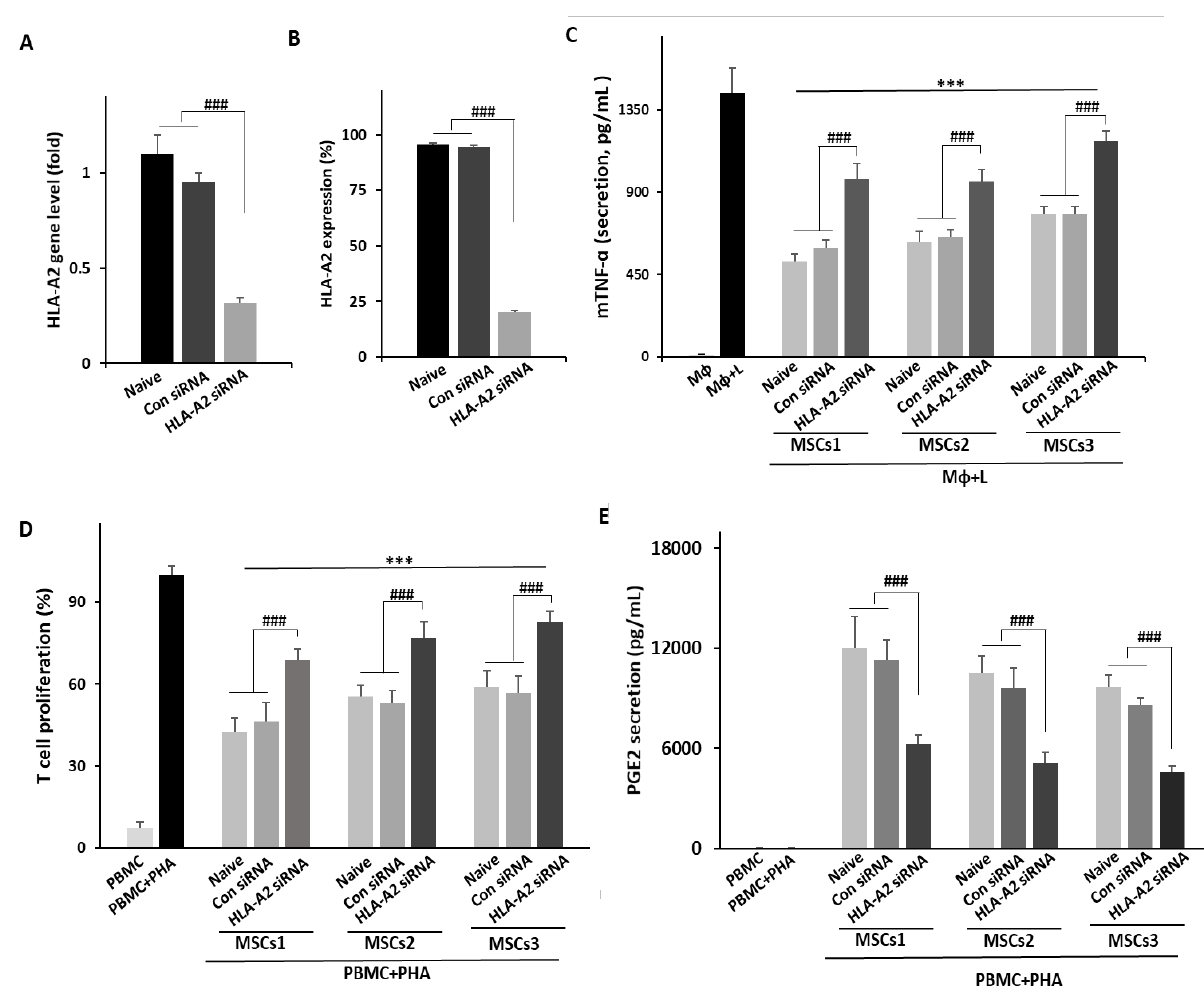
Figure 5. HLA-A2 knockdown in MSCs attenuates their therapeutic effects in vitro. Cells were transfected with control siRNA or HLA-A2 siRNA. ( A ) Gene expression and ( B ) protein levels of HLA-A2 were compared relative to those in non-transfected MSCs (naïve). ( A , B ) Error bars represent means ± SD, n = 3 per group; ### p < 0.001. ( C , E ) MSCs from three different lots of Group 1 were evaluated to confirm their therapeutic effects in vitro. ( C ) HLA-A2 siRNA-treated MSCs were co- cultured with LPS-induced RAW 246.7 cells and TNF- α levels were assessed via ELISA. Lower levels of TNF- α were detected in media from HLA-A2 knockdown MSCs. Error bars represent means ± SD, n = 3 per group; ### p < 0.001, *** p < 0.001 vs. M Φ + L. ( D ) Proliferation of human T cells based on MLR assays. PBMCs were co-cultured with MSCs. The proliferation of responding cells is shown as a percentage relative to the positive control (PBMC + PHA; set to 100%). ( E ) Levels of PGE2 in the culture media of cells from the MLR assay. Lower levels of PGE2 were noted in media from HLA-A siRNA MSCs. ( D , E ) Error bars represent means ± SD, n = 3 per group; ### p < 0.001, *** p < 0.001 vs. PBMC + PHA. M Φ : macrophage; L: LPS; PBMC: peripheral blood mononuclear cell; PHA: